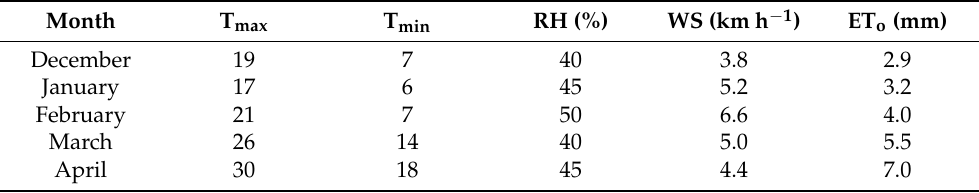
Table 2. Average monthly maximum (T max ) and minimum (T min ) temperature, relative humidity (RH), wind speed (WS), and reference evapotranspiration (ET o ) during the 2016–2019 growing